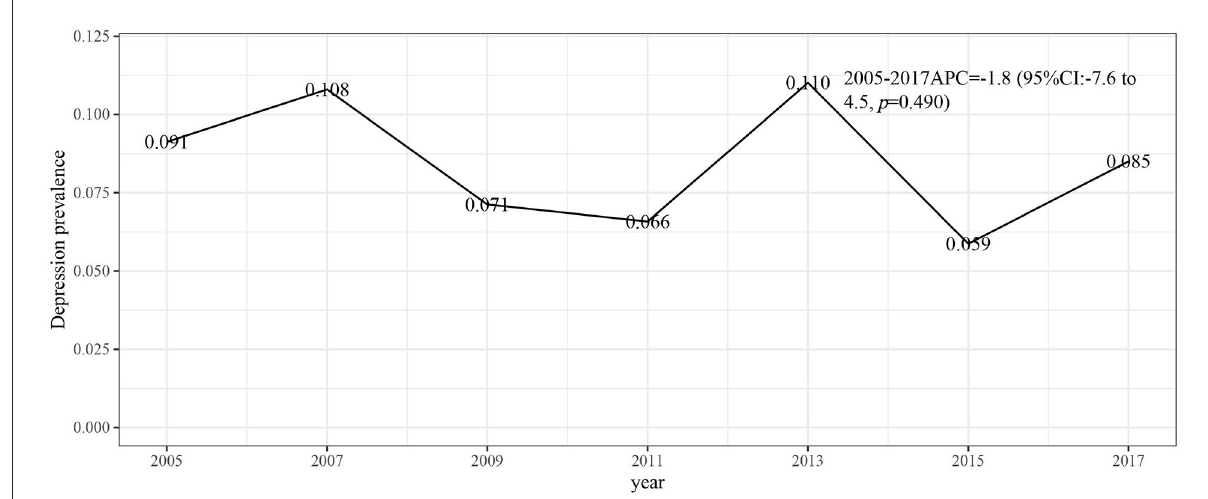
FIGURE2 Depression annual prevalence trend between 2005 and 2017. APC, annual percentage changes; CI, confidence interval.